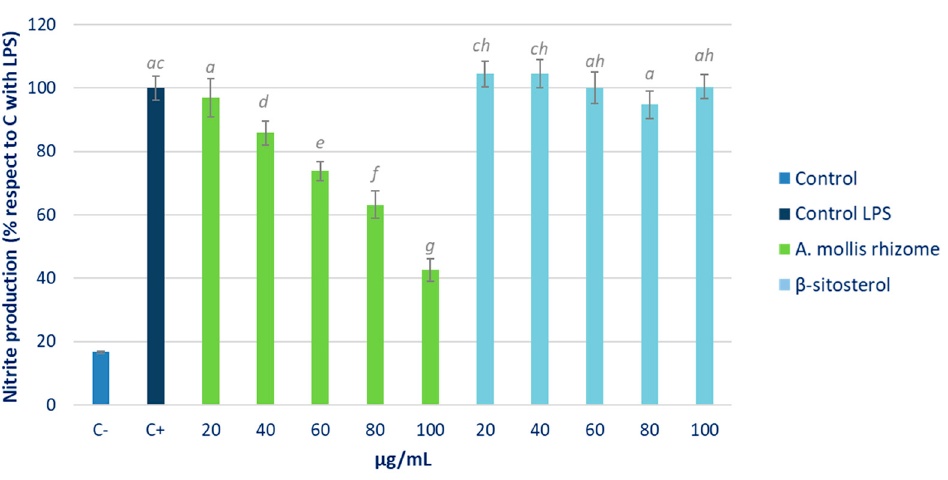
Figure 3. Percentage of NO with respect to the positive control stimulated with LPS (C+) in samples treated with various concentrations of Acanthus rhizome and β -sitosterol. Different letters indicate significant differences (ANOVA-Test, Bonferroni p < 0.05).